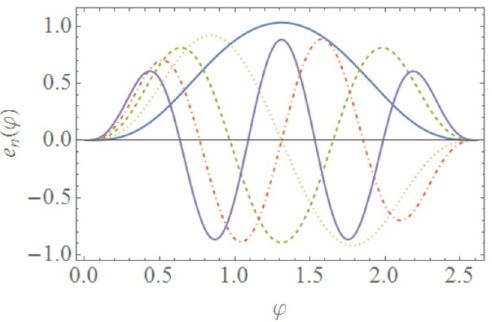
Figure 9 . The first five eigenmodes of the linearized (continuous) string equation of motion as a function of the polar-like